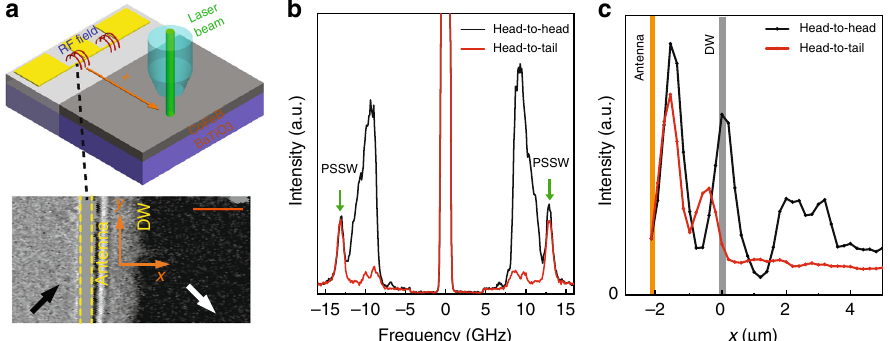
Fig. 2 Brillouin light scattering of spin-wave transmission. a Schematic and magneto-optical Kerr microscopy image of the μ -BLS measurement geometry. A microwave antenna on top of the CoFeB fi lm excites propagating spin waves. Transmission of these spin waves through a nearby head-to-head or head-to- tail domain wall is recorded by scanning the μ -BLS laser beam across the wall (orange arrow in top panel). The orange scale bar in the bottom panel corresponds to 2 μ m. b μ -BLS spectra measured at a fi xed position, 4.5 μ m from the antenna, and by scanning the rf excitation frequency in the range 5 – 15 GHz. Dissimilar transmission of propagating spin waves through the broad 90° head-to-head and narrow 90° head-to-tail domain wall is illustrated by the intensity peaks that range from ±7.7 to ±12.2 GHz. The peak recorded at 12.6 GHz on both the Stokes and anti-Stokes side of the spectra indicates thermal con fi gurations. The excitation frequency in this measurement is 10.85